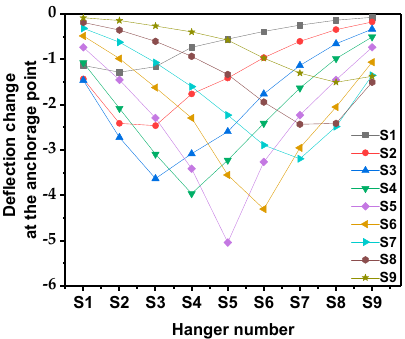
12 of 17 Figure 11. Cable force of south hangers.